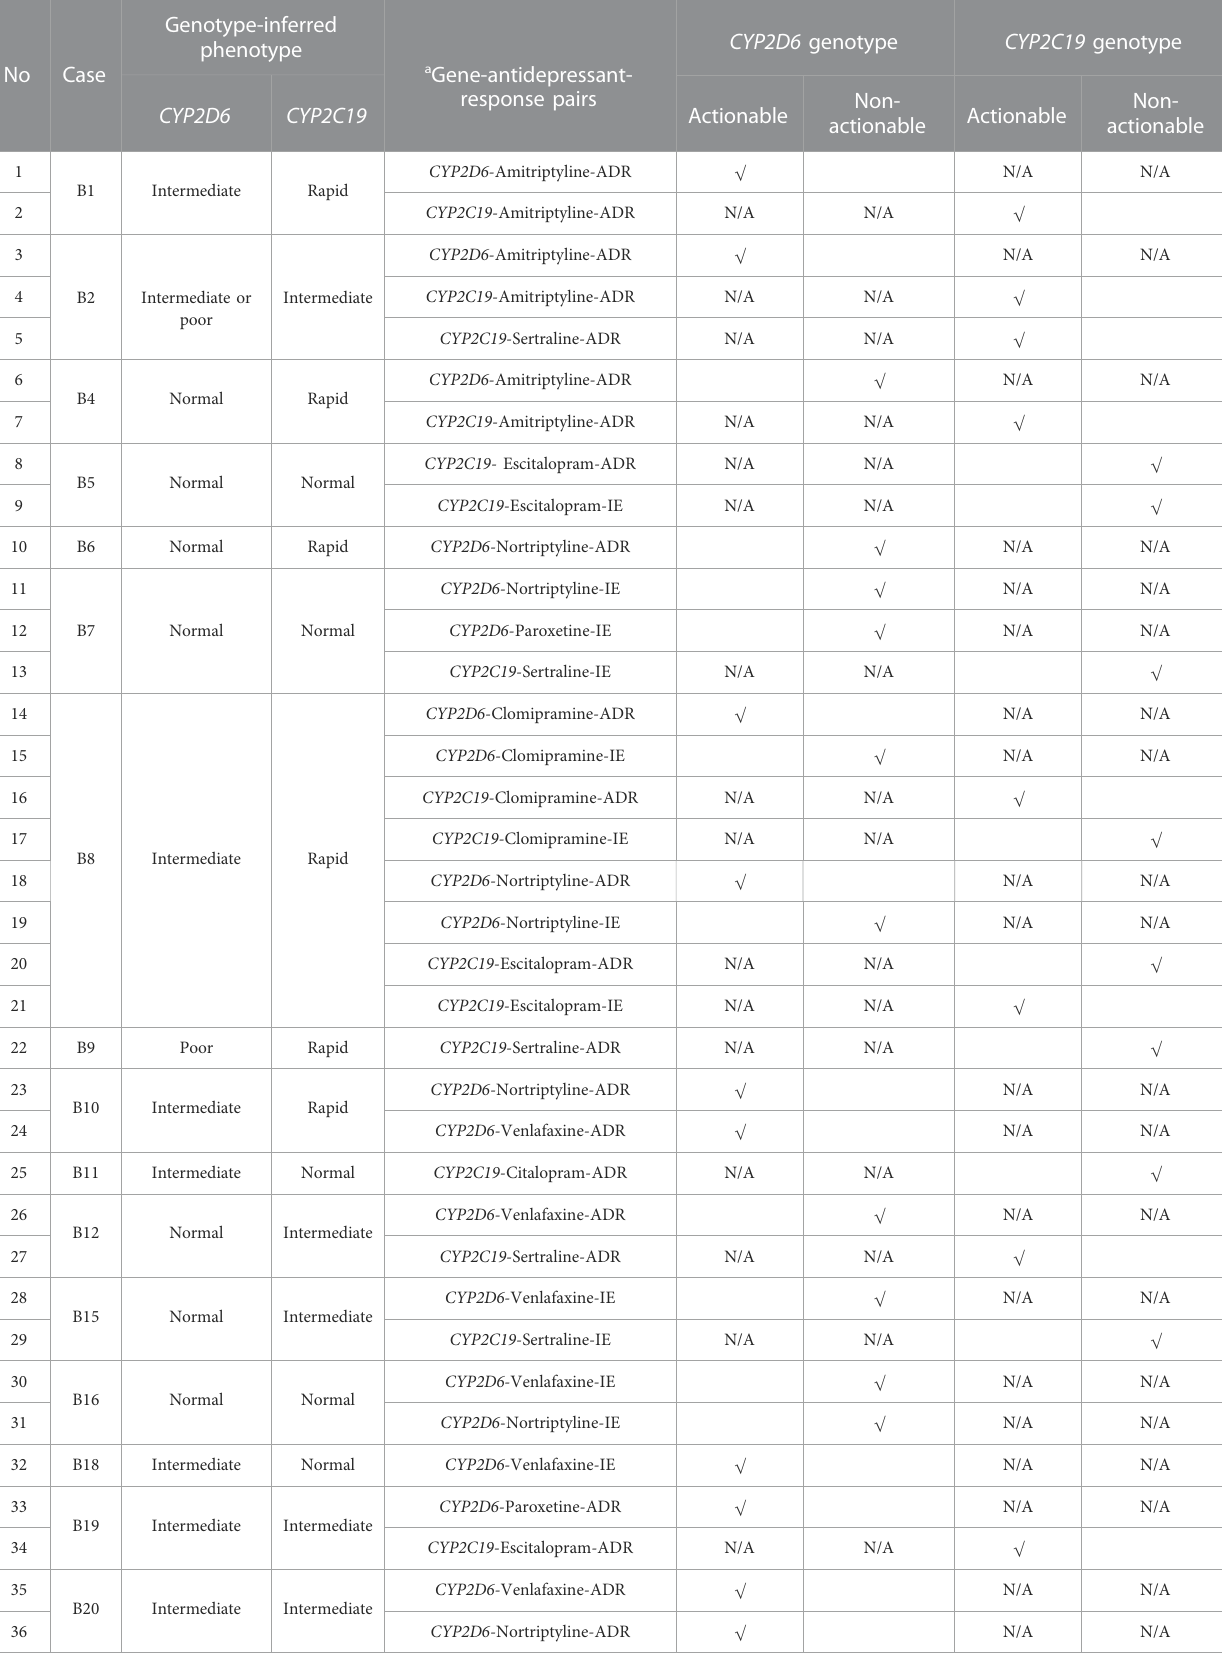
TABLE 3 Analysed gene-antidepressant-response pairs and actionability of CYP2D6 and CYP2C19 pharmacogenetics (N = 79).